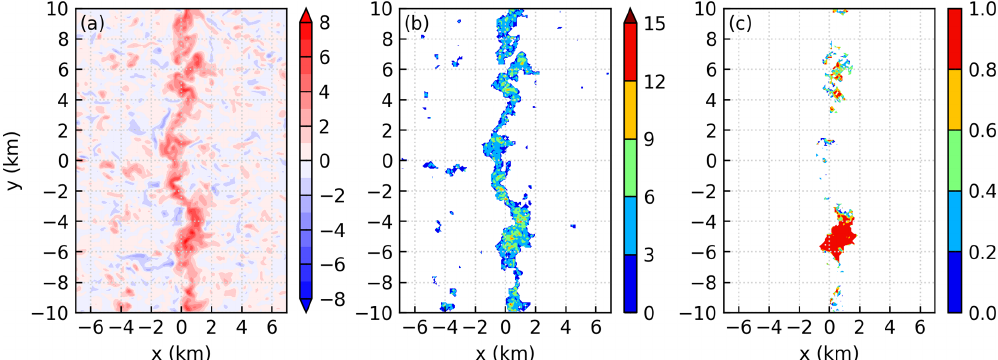
Figure 9. (a) The vertical velocity at z = 0 . 88km. (b) The number of parcels that are lifted at each grid point. (c) The fraction of parcels that rise above 4km in all parcels that are lifted. The parcels are released at t = 7h 35min and tracked forward for 20min. The results are at t = 7h 47min of simulation THF700.